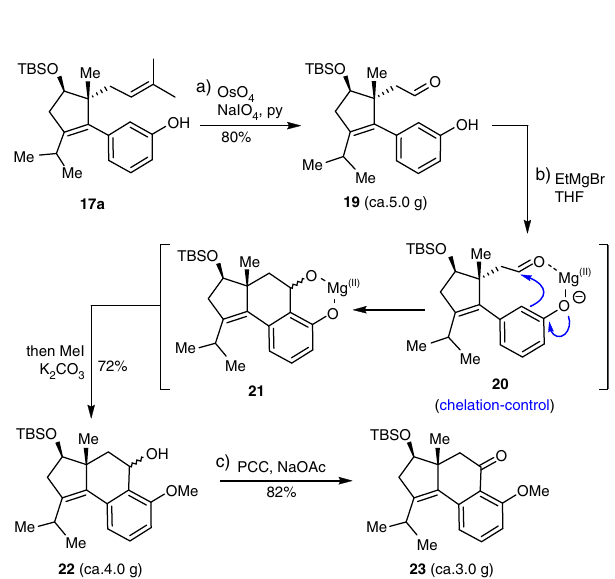
Fig. 4 Synthesis of the tricyclic compound 23 . Reagents and conditions: (a) OsO 4 (4 mol%), NaIO 4 (5.0 equiv), pyridine (3.0 equiv), dioxane/H 2 O (v/v = 5:1), 80 ° C (80%); (b) EtMgBr (1.1 eqiuv, 1.0 M in THF), − 78 to 40 o C, overnight, then K 2 CO 3 (2.0 equiv), MeI (5.0 equiv), and DMF were charged in situ, 55 o C, 10 h (72%); (c) PCC (4.0 equiv), NaOAc (4.0